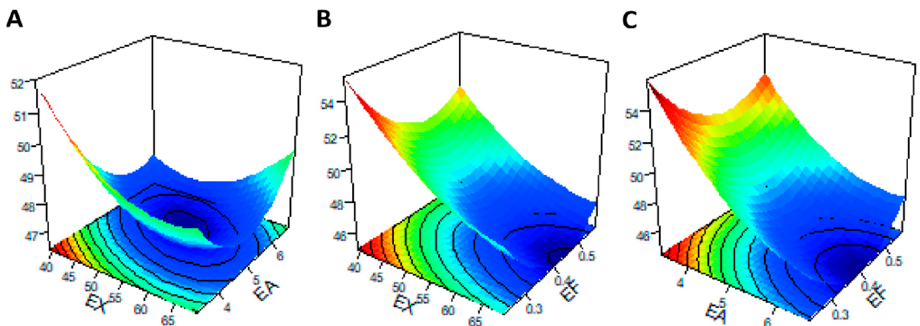
Figure 4. Response surface and contour plots of the interaction effects between enzyme addition levels for factors [( A ): EX/EA; ( B ) EX/EF; ( C ) EA/EF] on the in vitro dry matter digestibility (y 2 ). The abscissa axis at the bottom of the figure represents the two enzyme factors, respectively, and the vertical axis upward represents the corresponding response index (y). The associated contour plots are composed of the densely arranged circles on the underside.